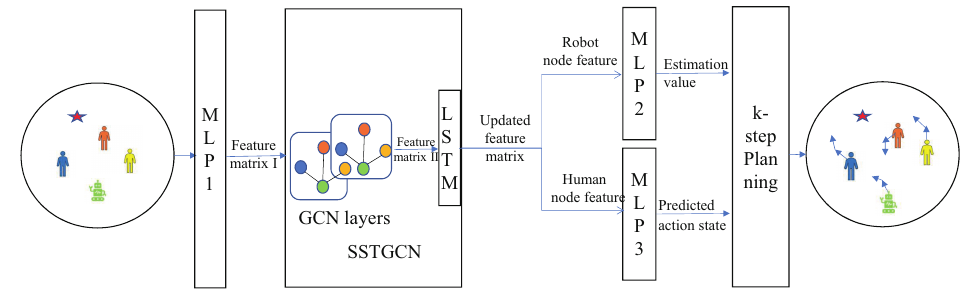
Figure 2. Structure of the